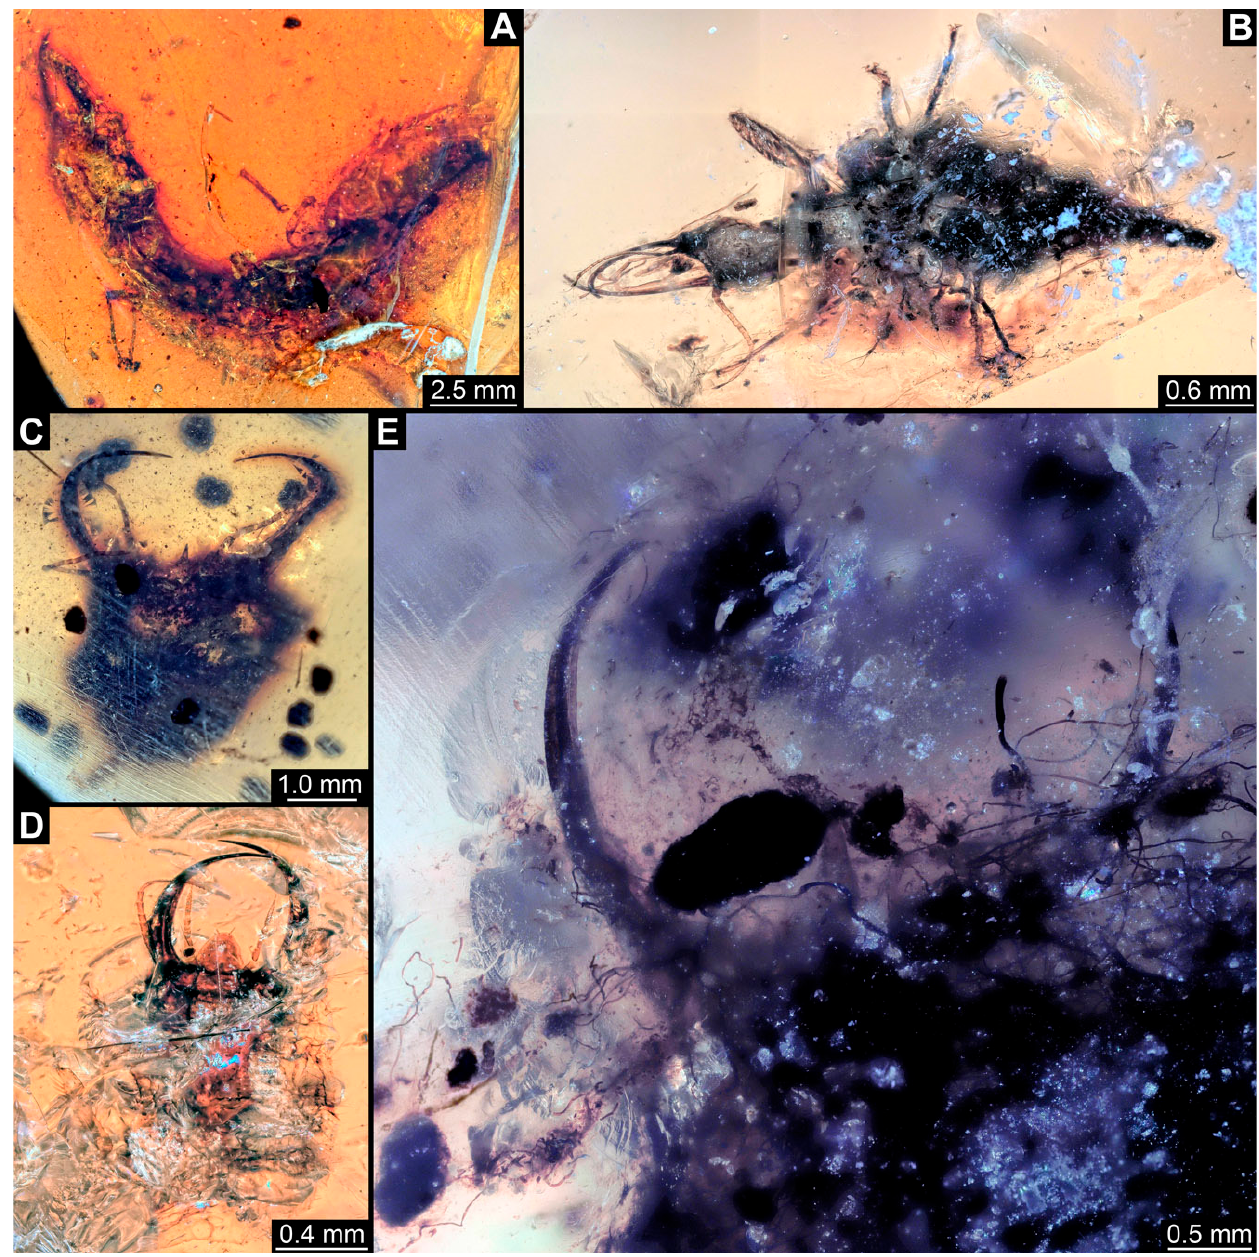
Figure 1. Specimens in Myanmar amber. ( A ) Specimen 71 (PED 0845), dorsal view. ( B ) Specimen 53 (PED 0150), dorsal view. ( C ) Specimen 67 (PED 0625). ( D ) Specimen 64 (PED 0584). ( E ) Specimen 54 (PED 0267). (3) Specimen 55 (PED 0322) is preserved in Cretaceous Myanmar amber. Both lateral sides are accessible. The head is only accessible in the lateral view (Figure 2F,G). The la- brum seems to have a triangular shape in the dorsal view. The antennae bear prominent setae at the distal ends. Trumpet-shaped empodia at the end of the locomotory